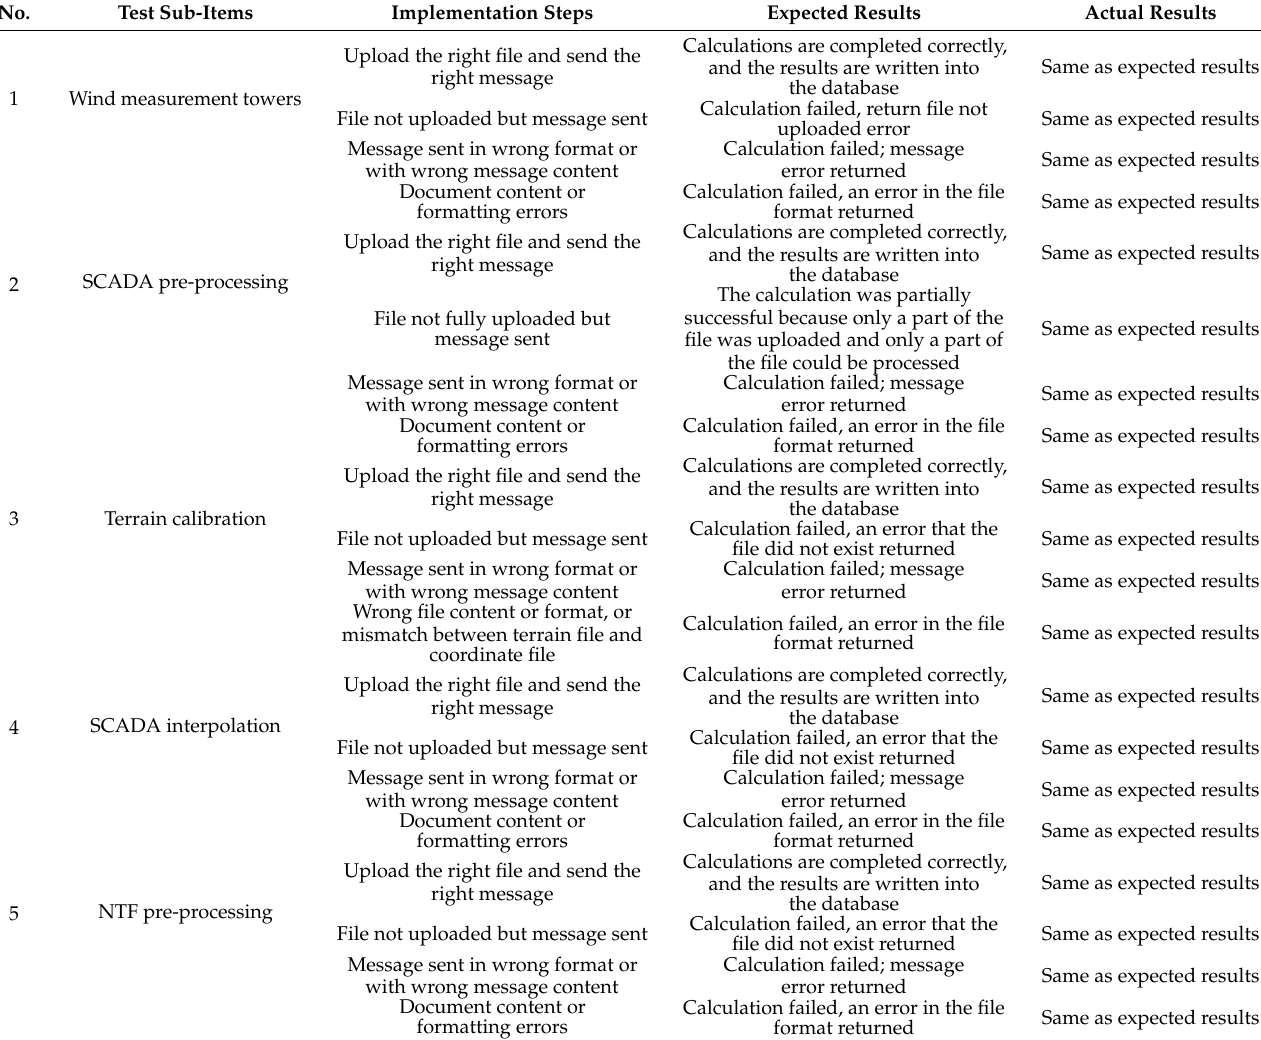
Table 5. SQS Test